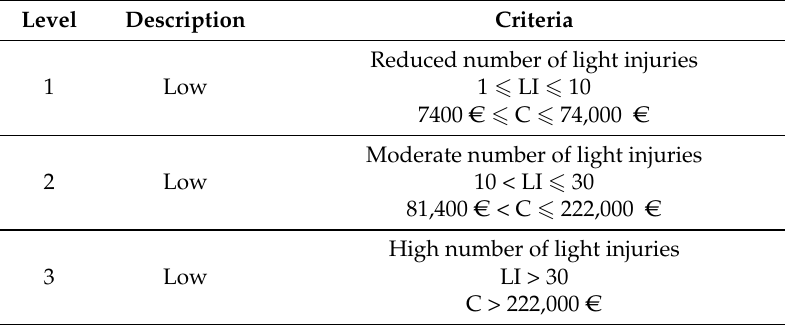
Table 2. Evaluation criteria to assess social